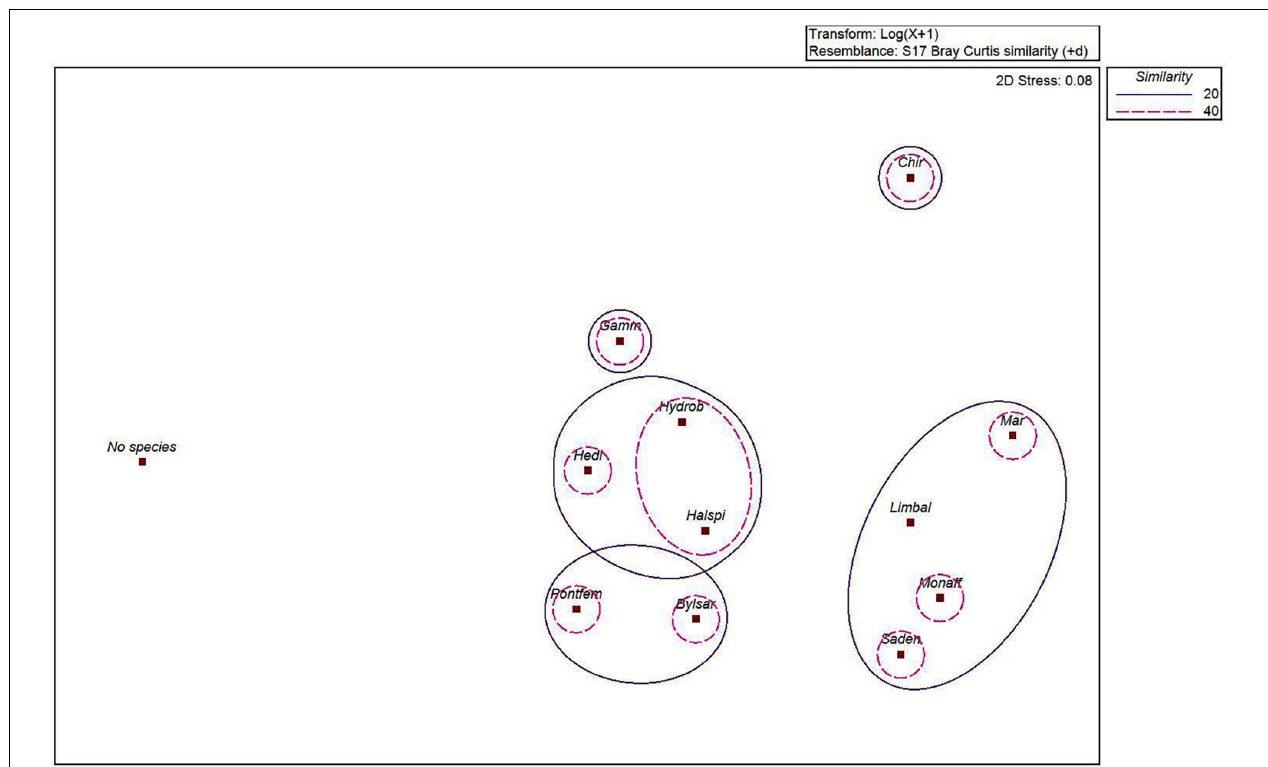
FIGURE 2 | MDS-ordination on the similarity of the species ( Marenzelleria spp., Bylgides sarsi , Hediste diversicolor , Halicryptus spinulosus , Limecola ( Macoma ) balthica , Hydrobia spp., Saduria entomon , Monoporeia affinis , Pontoporeia femorata , Gammarus spp., Chironomidae and variable “No species” (referring to samples lacking macrofaunal specimens) in an environmental space. 2D stress level of the test was 0.08, indicating sufficient statistical validity of the test. Bray Curtis similarity measure was used to define the similarity of species. Similarity levels of 20% (continuous line) and 40% (dashed line) are illustrated by contours.